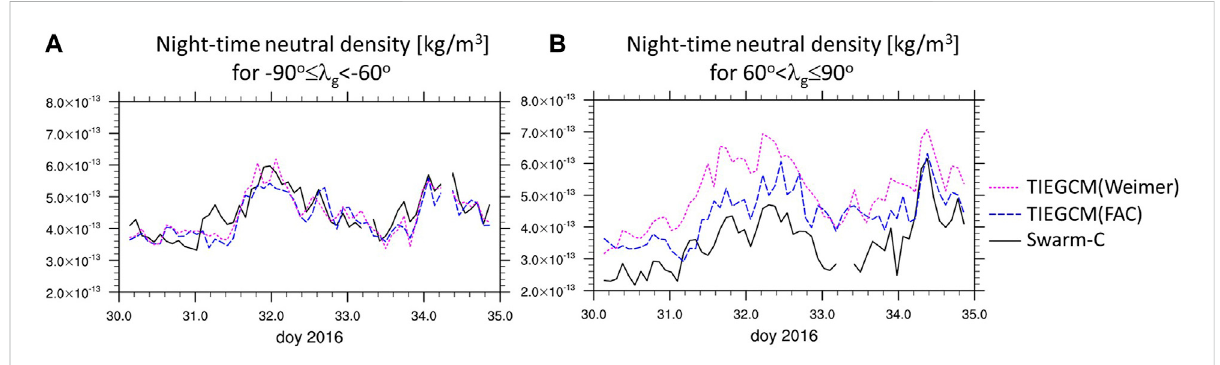
FIGURE 9 Night-orbit high latitudinal average neutral density variations of Swarm-C (black solid lines), TIEGCM(Weimer) (magenta dotted lines), and TIEGCM(FAC) (blue dashed lines) for night-time orbit for − 90 0 ≤ λ g < − 60 0 (A) and for 60 0 < λ g ≤ 90 0 (B) .